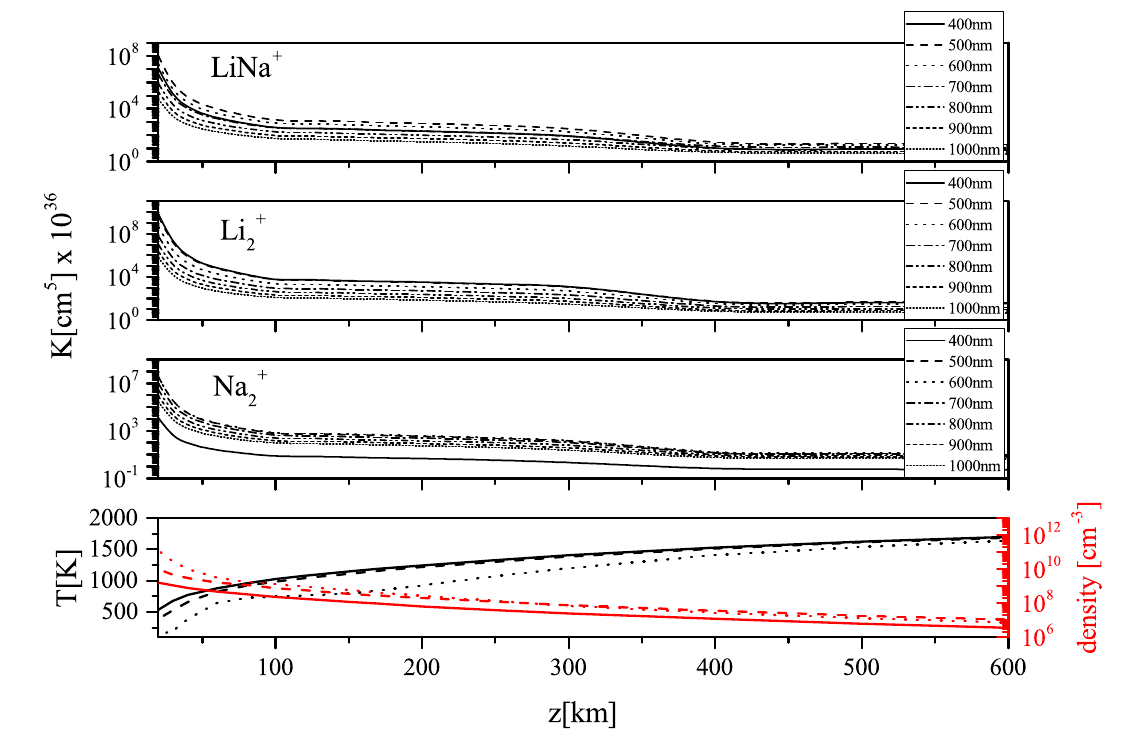
Figure 5. Lower panel: temperature and density altitude profiles for low-density (solid line), moderate-density (dashed) and high-density (dotted line) models of Io’s atmosphere. Upper panels: the total photodissociation rate coefficient for Na + Li + and LiNa + for an example of the low-density model of Io’s atmosphere 2